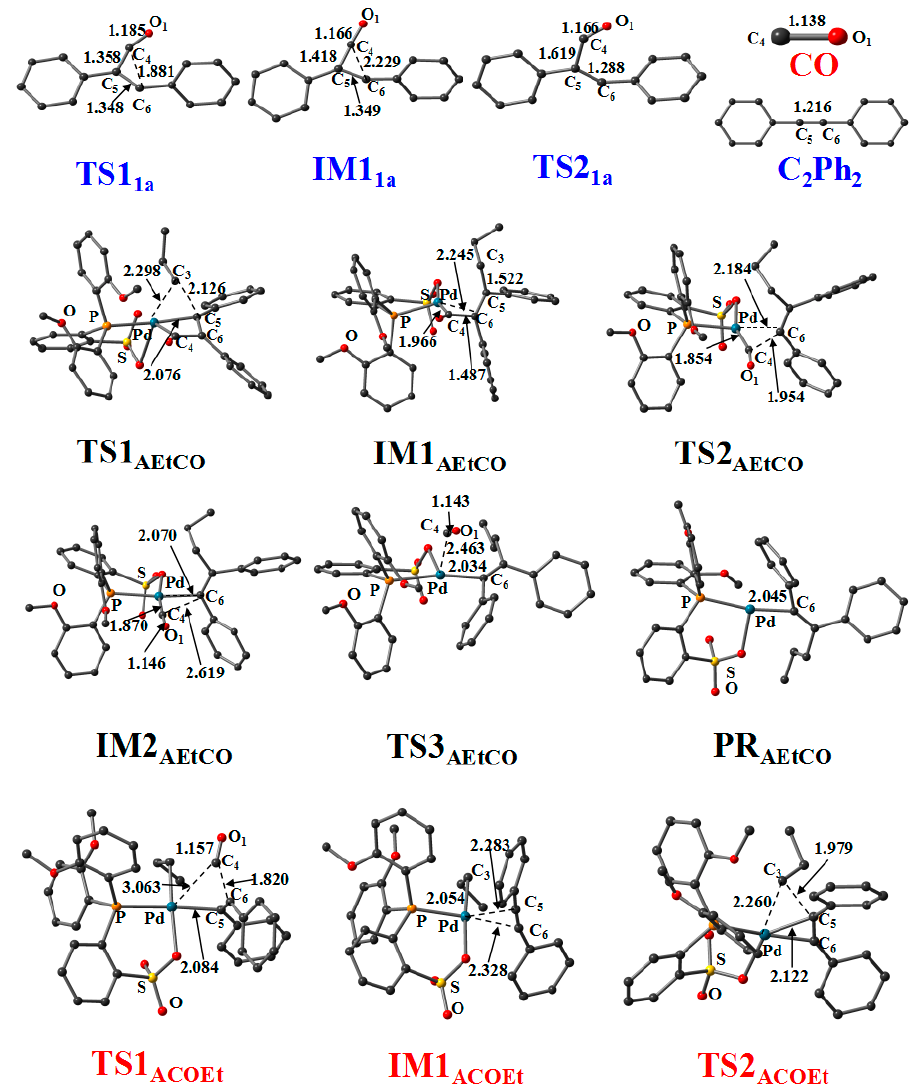
Figure 8. Optimized structures in the pathway of generation CO from cyclopropenone shown in Figure 7 (Path A CO , blue; Path B CO , black; Path B’ CO , red), the key length is in angstroms. For clarity, the hydrogen atom is omitted.